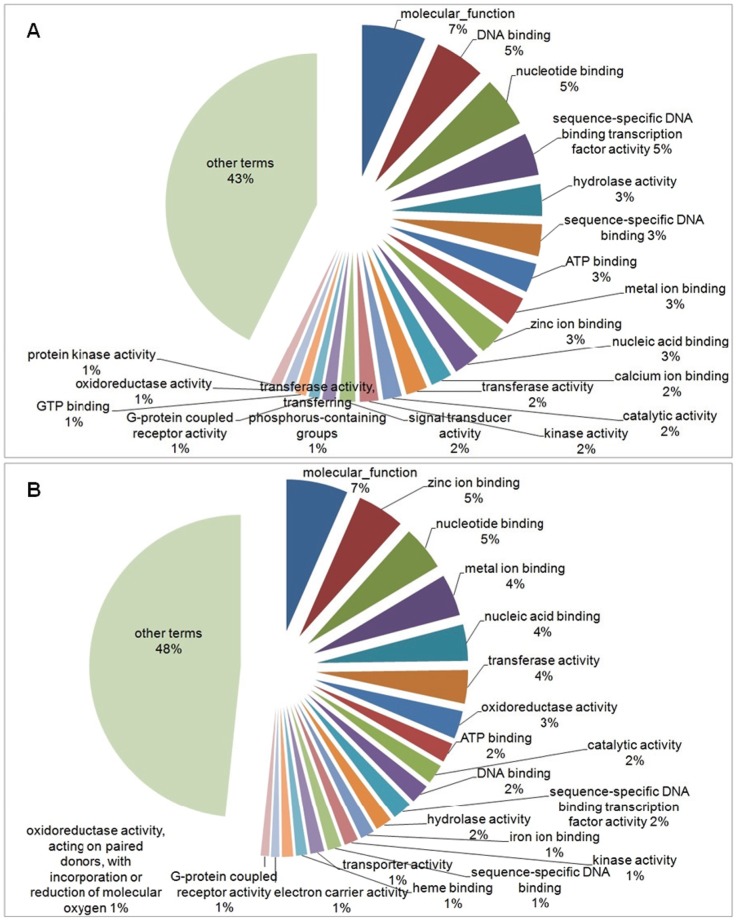
Pie-chart of Top20 GO terms found in the Molecular Function category.Representation of Top20 GO terms results from the down- (a) and up-regulated genes (b) for Molecular Function category, in the experimental group compared to control. The other terms, in addition to Top20, were represented together.